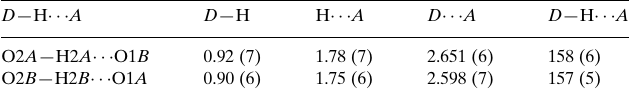
Hydrogen-bond geometry (A˚ , (cid:3)